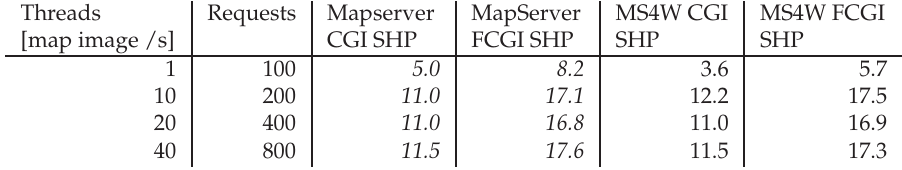
Table 4: WMS results comparison. FOSS4G benchmark 2009 in italic. CGI: Common Gate-